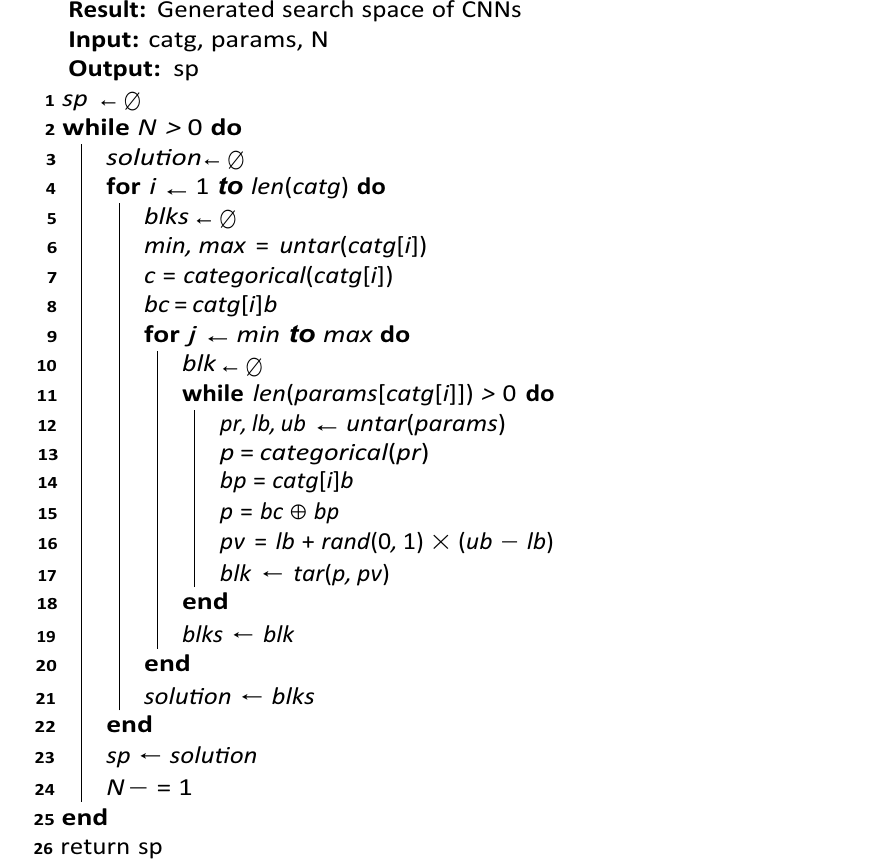
Algorithm1: BSCB for genera(cid:21)ng search space Result: Generated search space of